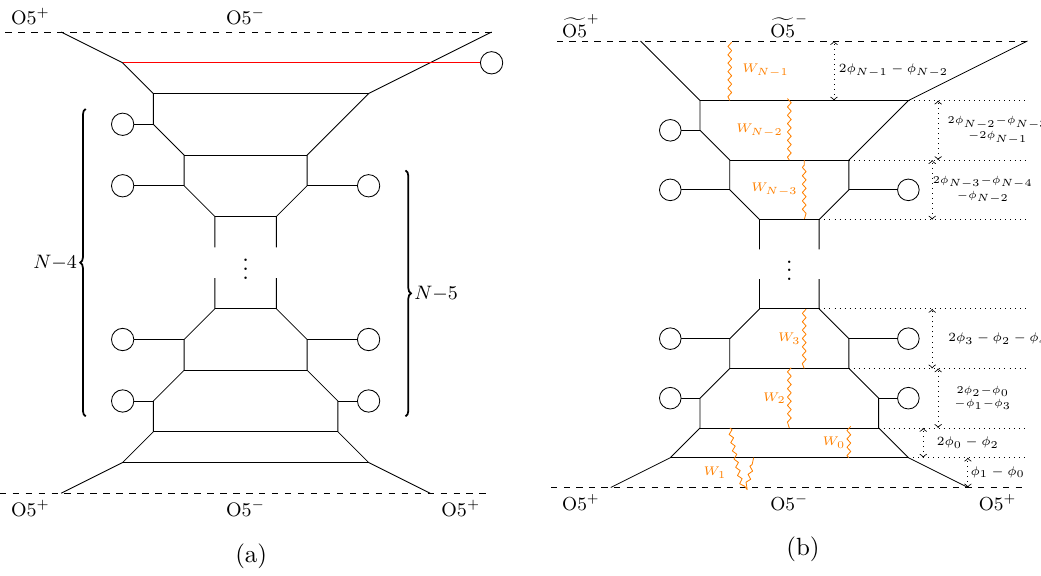
Figure 5. Partial Higgs mechanisms for the brane web displayed in figure 4. In (a), SO(2 N ) is Higgsed to SO(2 N − 1) via moving the red brane segment onto the top O5-plane. The associated fundamental flavor is only charged under the gauge symmetry. In (b), the brane web for the SO(2 N − 1) theory with 2 N − 9 fundamentals is shown after the transition of figure 7. The W- boson masses are functions of the dynamical Kähler parameter and the dependence is mediated via the Cartan matrix of b B (1) N − 1